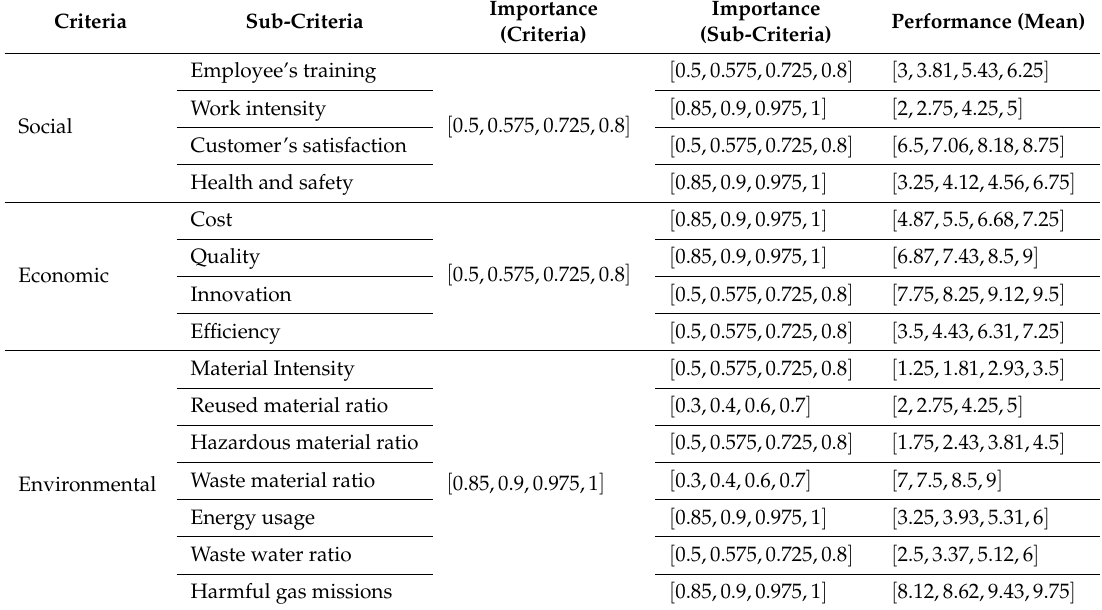
Table 7. The detailed data about importance weights and performance rates for this particular